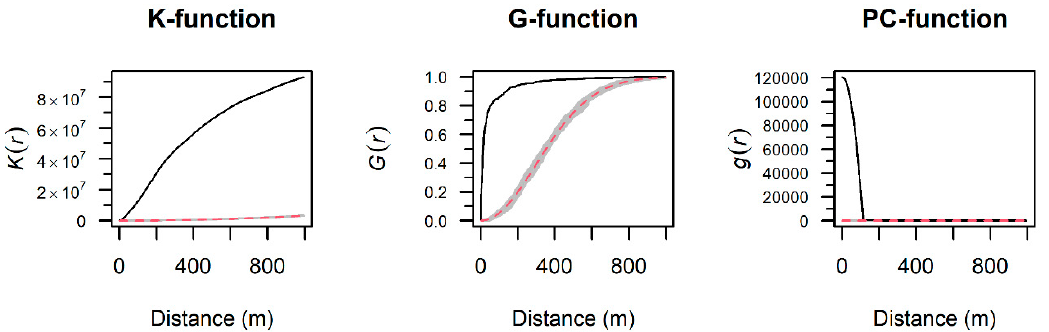
Figure 6. Results of testing for second-order interaction using K-, G- and PC-functions compared to 39 simulated realizations of complete spatial randomness (CSR). Black line is the empirical function for archaeological deposits, the red-dashed lines is the theoretical expectation under the null model of CSR, the grey shaded region is the simulation envelope (equivalent to p = 0.05).